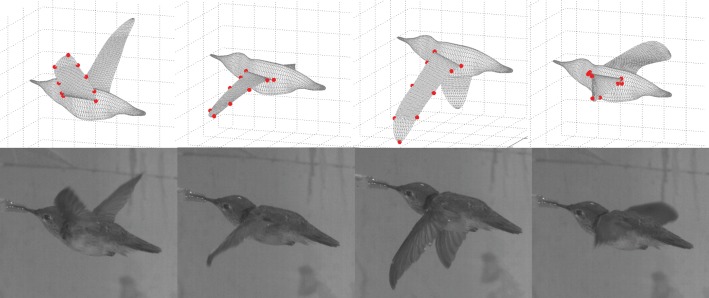
Reconstructed wing positions and corresponding snapshots from the camera view.